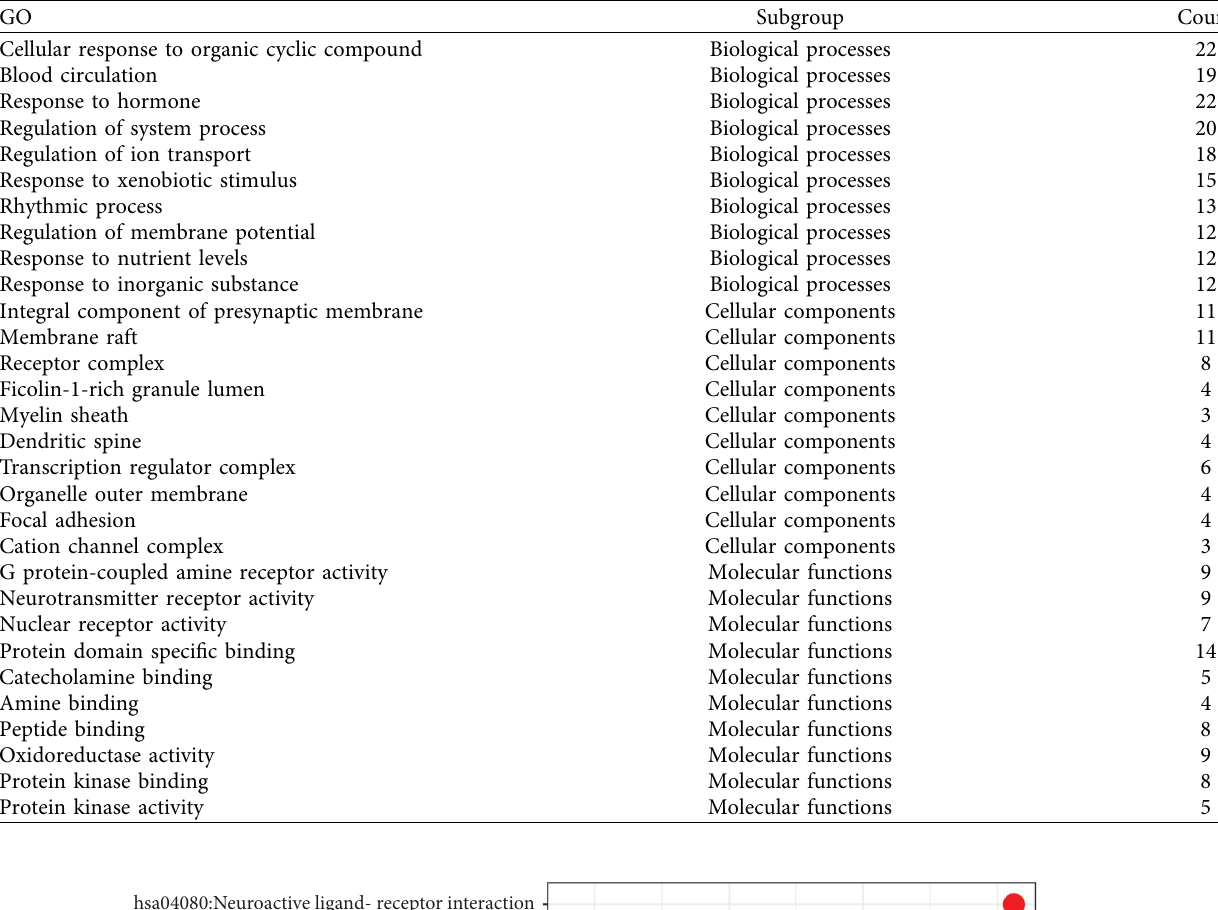
Table 3: Information on GO enrichment analysis data.